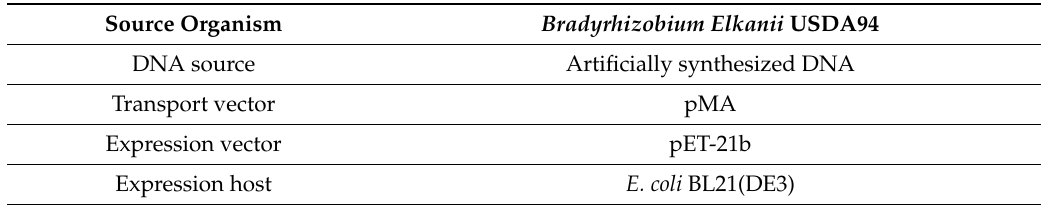
Table 1. Production specifics for DbeA ∆